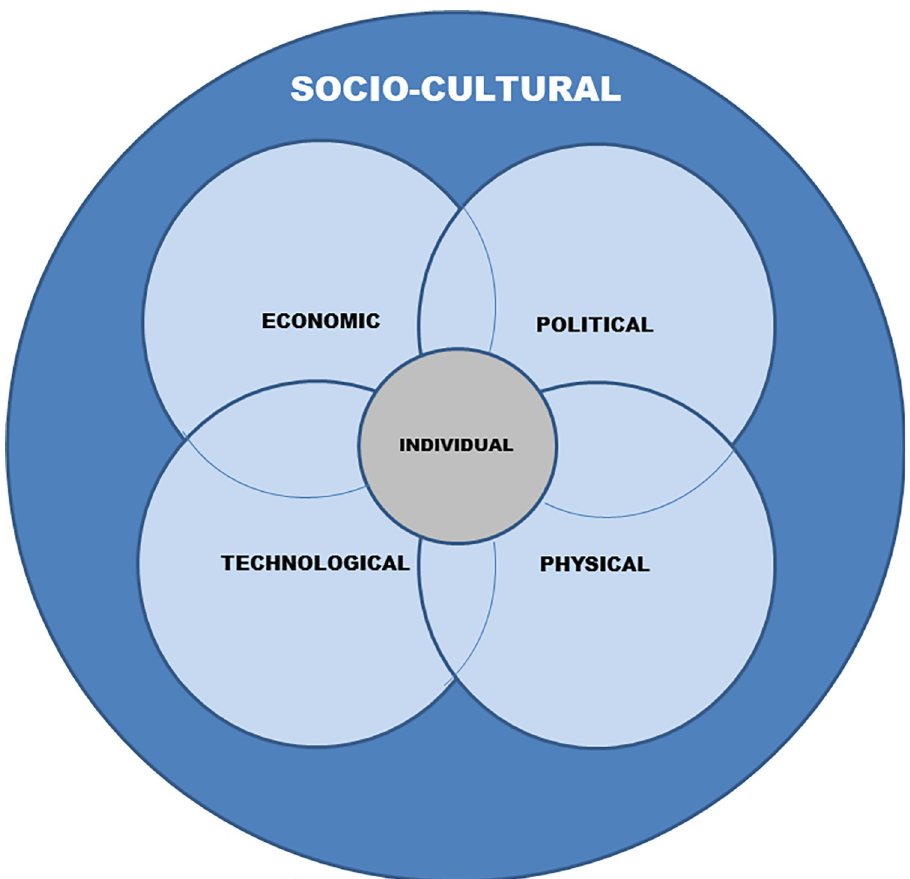
Fig 1. Socioecological model for community engagement activities. The individual environment representing individuals within the community is in the centre [Grey], the first level of influence. The intermediate levels of influence are economic, political, technological and physical [light blue]. The overarching level of influence is the socio-cultural environment including the community [dark blue]. The environmental influences overlap as some factors influencing community engagement in the health programme are nested within multiple environments as is the nature of SEM